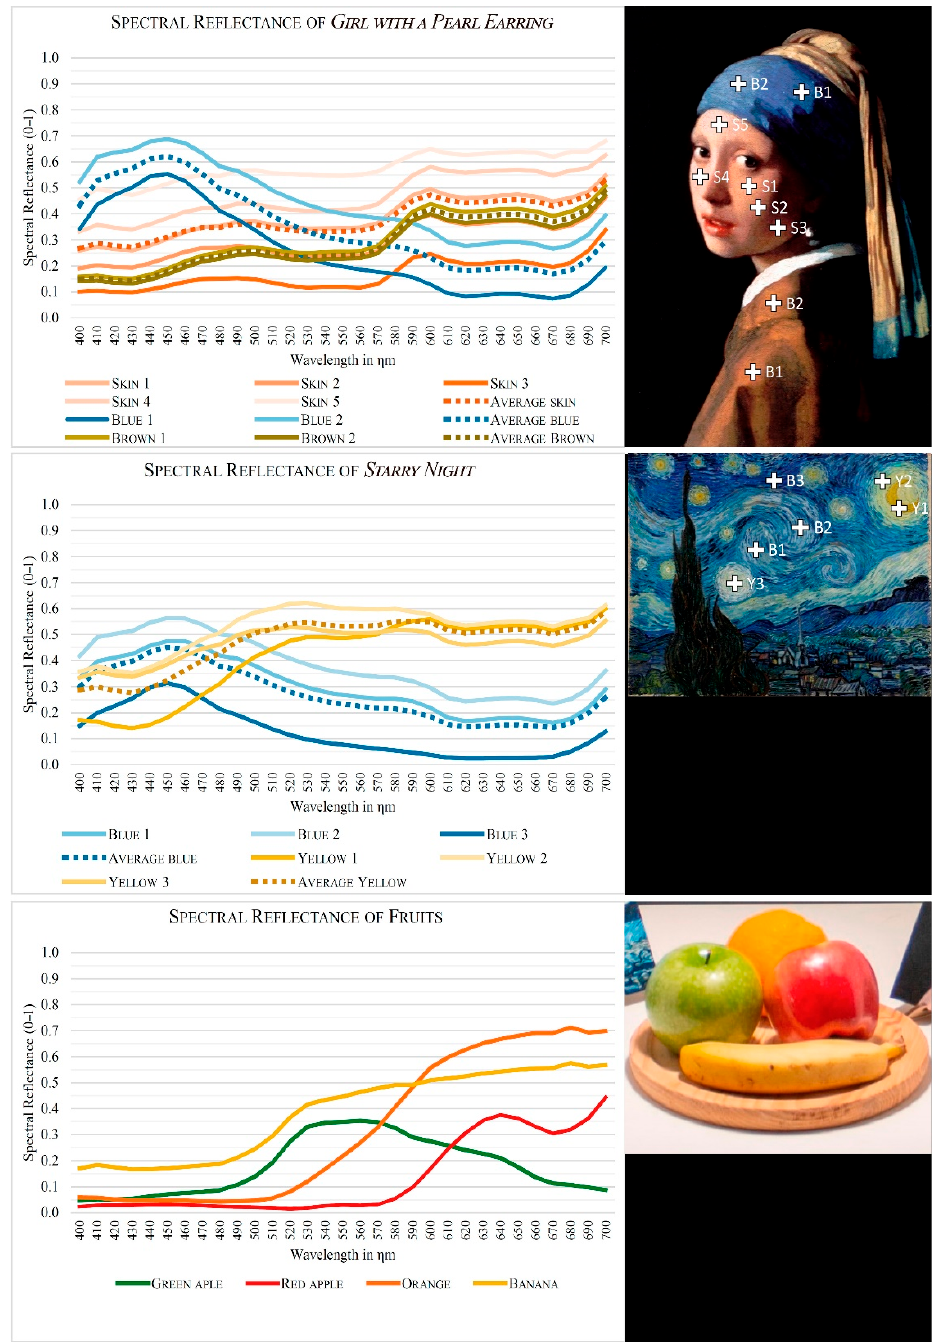
Figure 6. Spectral reflectance values of color samples. From above to below: Girl with a Pearl Earring , The Starry Night and fruit scenario.